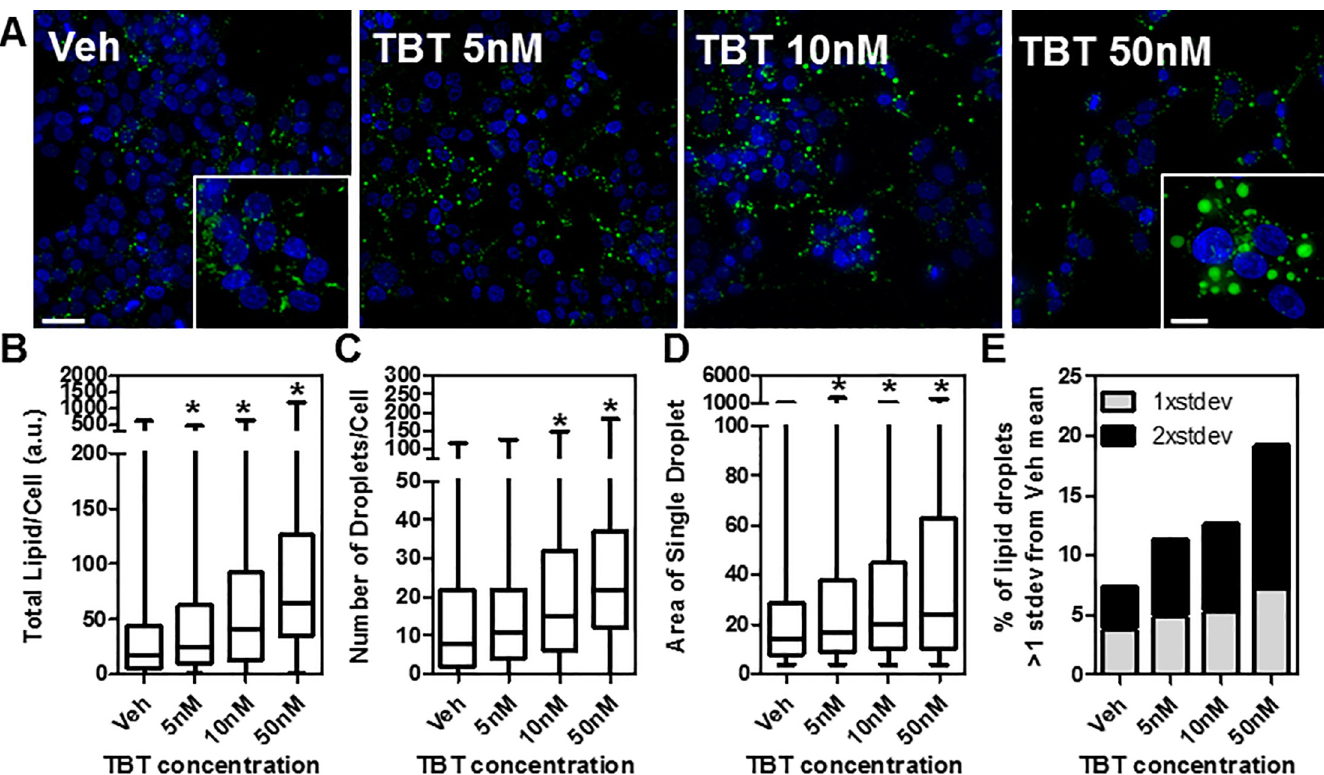
Fig 1. The obesogen tributyltin (TBT) increases lipid content in HepaRG human liver cells. A) HepaRG cells were grown in the presence of TBT (5–50 nM) or vehicle (DMSO) for 14 days, lipid droplets were stained with LipidTox and imaged using deconvolution epifluorescence microscopy; max projection images are shown. B-E) High content image analysis of the effects of TBT at the single cell and single lipid droplet level. n > 400 cells/condition analyzed from two independent experiments. � p < 0.05 by ANOVA (Kruskal-Wallis test). Scale bar: 25 μ m (10 μ m inset).